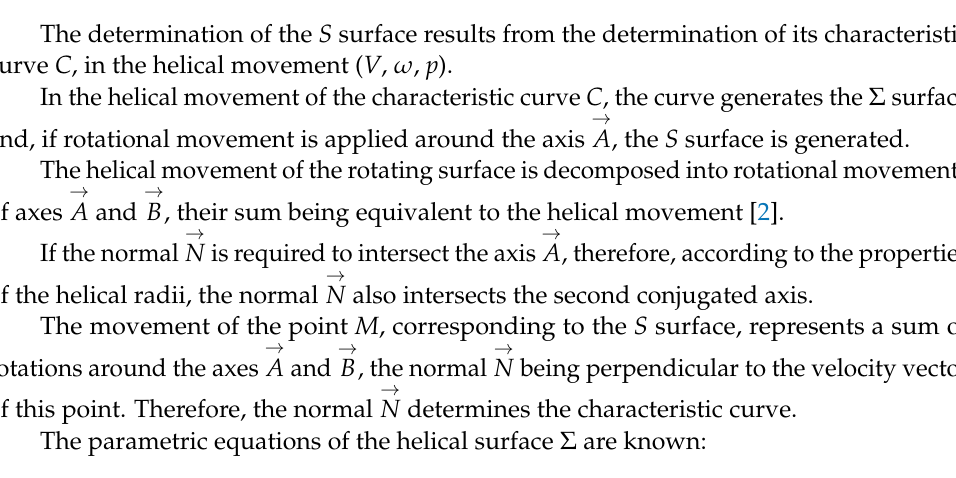
tic curve C , in the helical movement ( V , ω , p ). curve C , in the helical movement ( V , ω , p